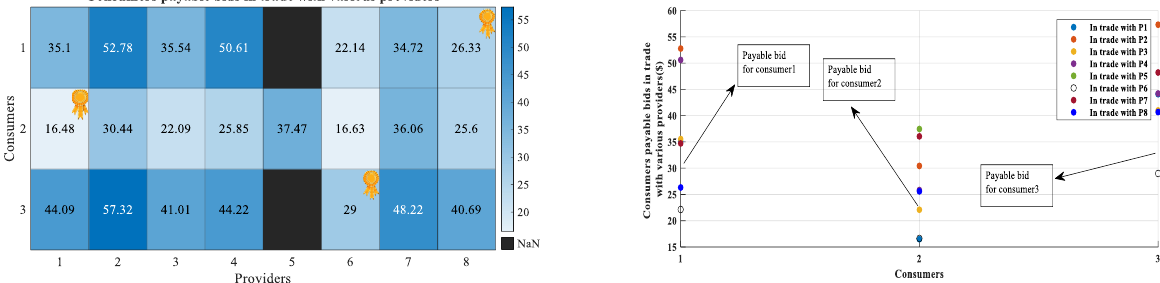
Table 3. Required rounds and winning providers using the proposed strategy calculated with dif- ferent reliability coefficients.